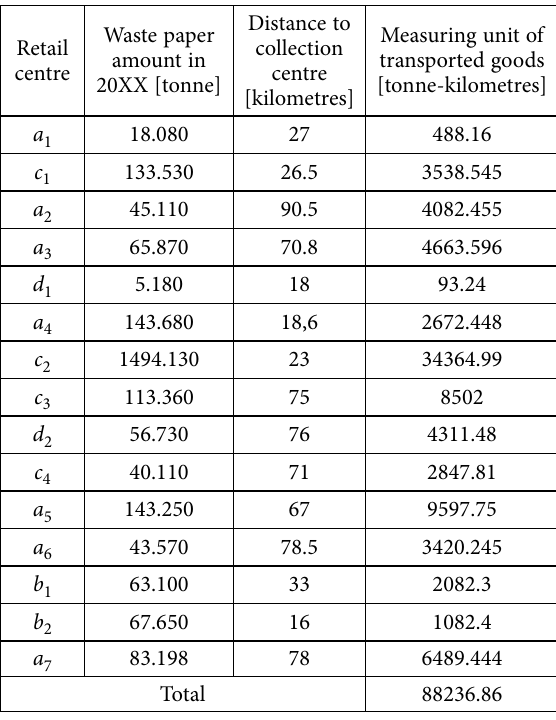
Road distance [km] Individual retail centres Collection centre